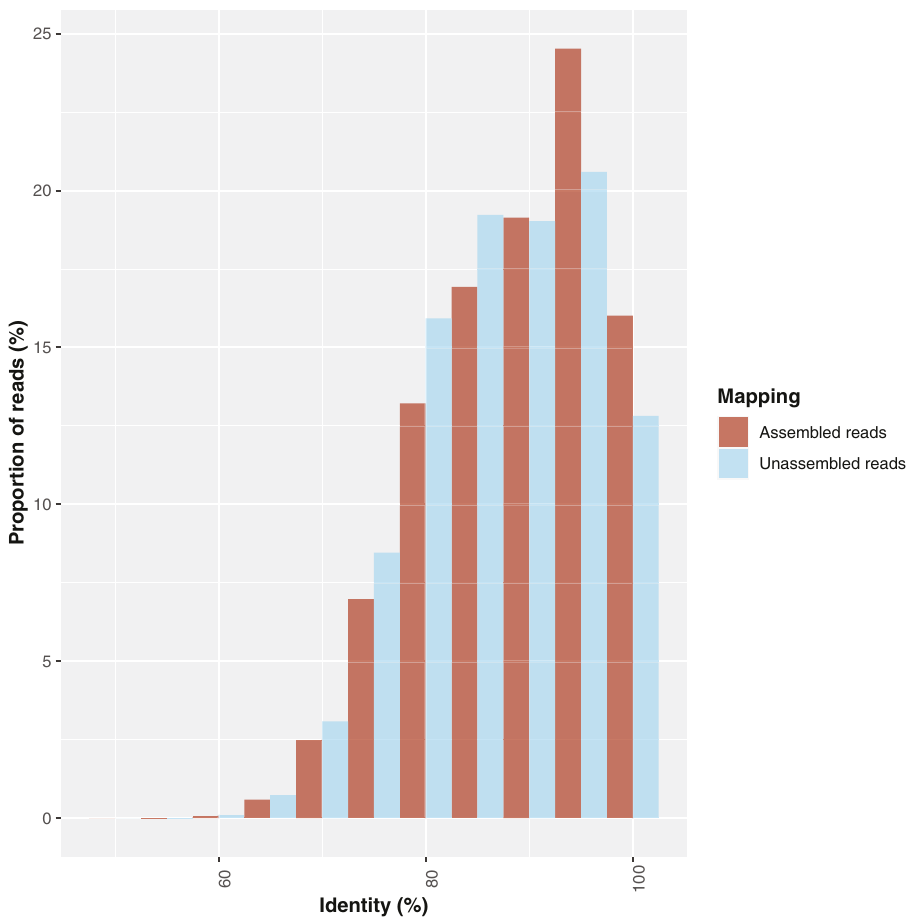
Fig. 4 Distribution of the identities between assembled and unassembled reads against the UNIREF90 database. The assembled and unassembled reads were mapped against UNIREF90 database (results obtained from UNIREF100 were displayed in the supplementary materials Fig S5) by using DIAMOND [35] with the blastx